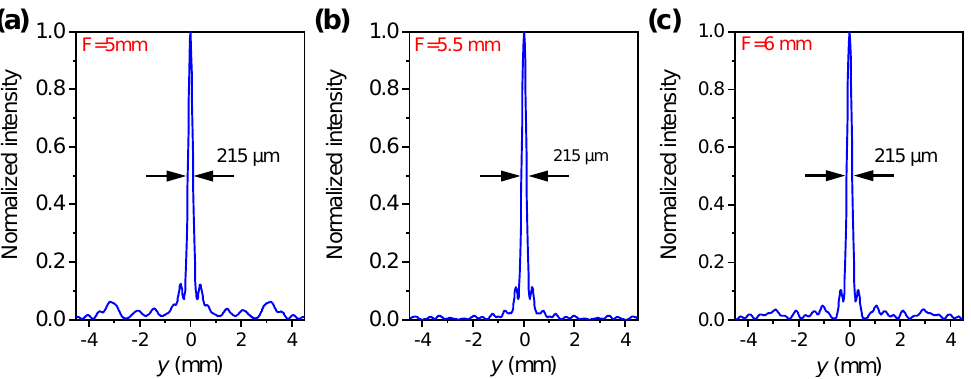
Figure 9. Normalised electric field intensity along y axis (when z locates at the focal points) for ( a ) F = 5 mm, ( b ) 5.5 mm and ( c ) 6 mm,